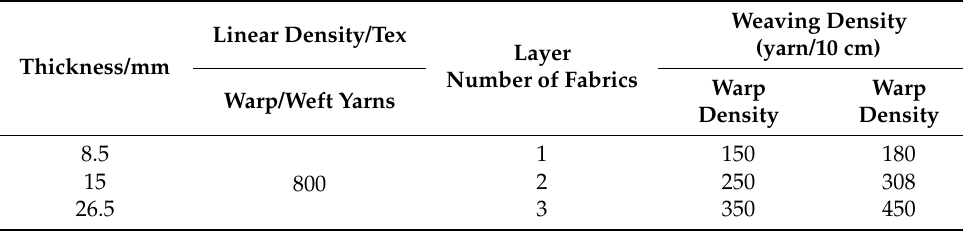
Table 1 indicates the specific operating parameters. Table 1. Weaving parameters of 3D gradient honeycomb woven Table 1. Weaving parameters of 3D gradient honeycomb woven fabrics.